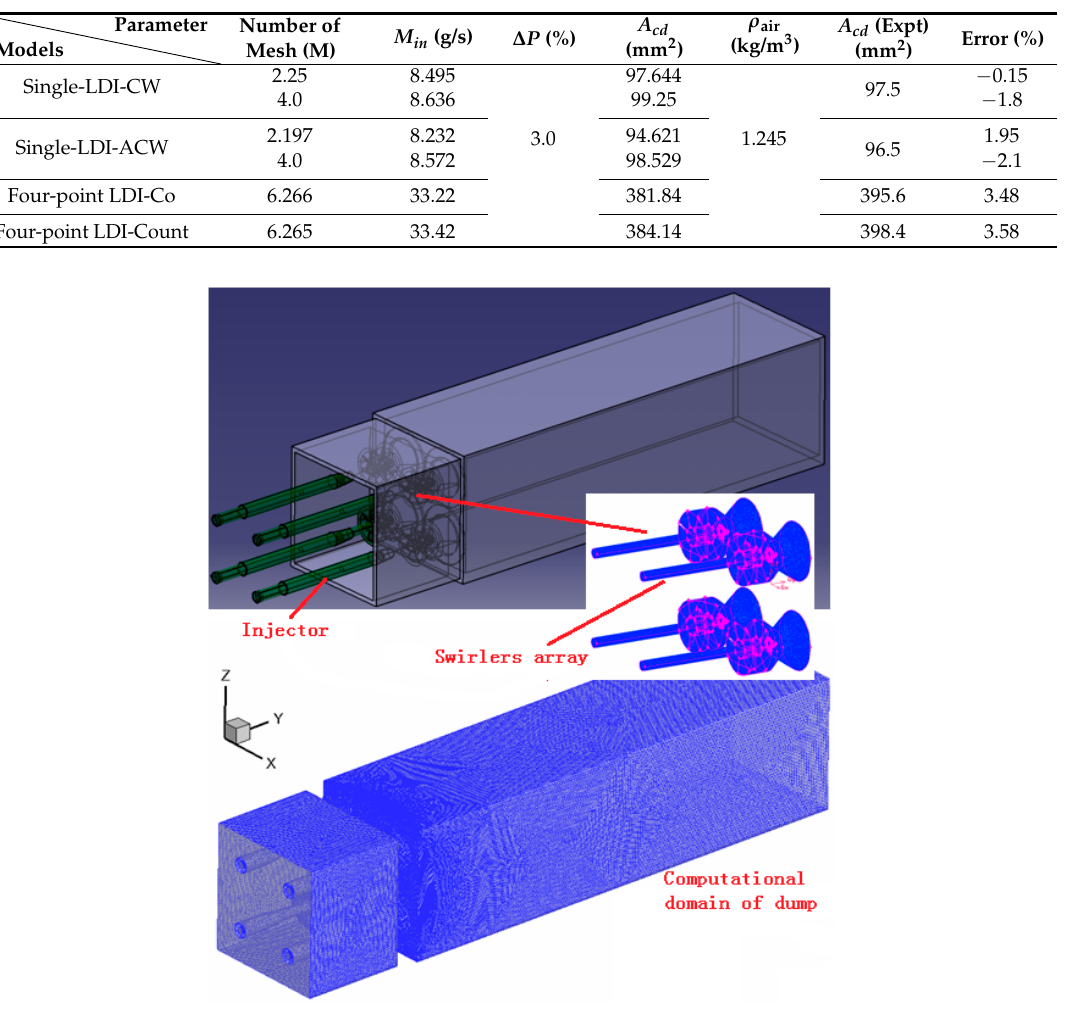
Figure 3. Mesh for a four-point LDI combustor.